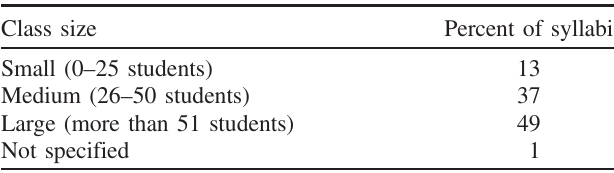
TABLE II. The class size of the courses featured in the N ¼ 77 syllabi that have been analyzed.